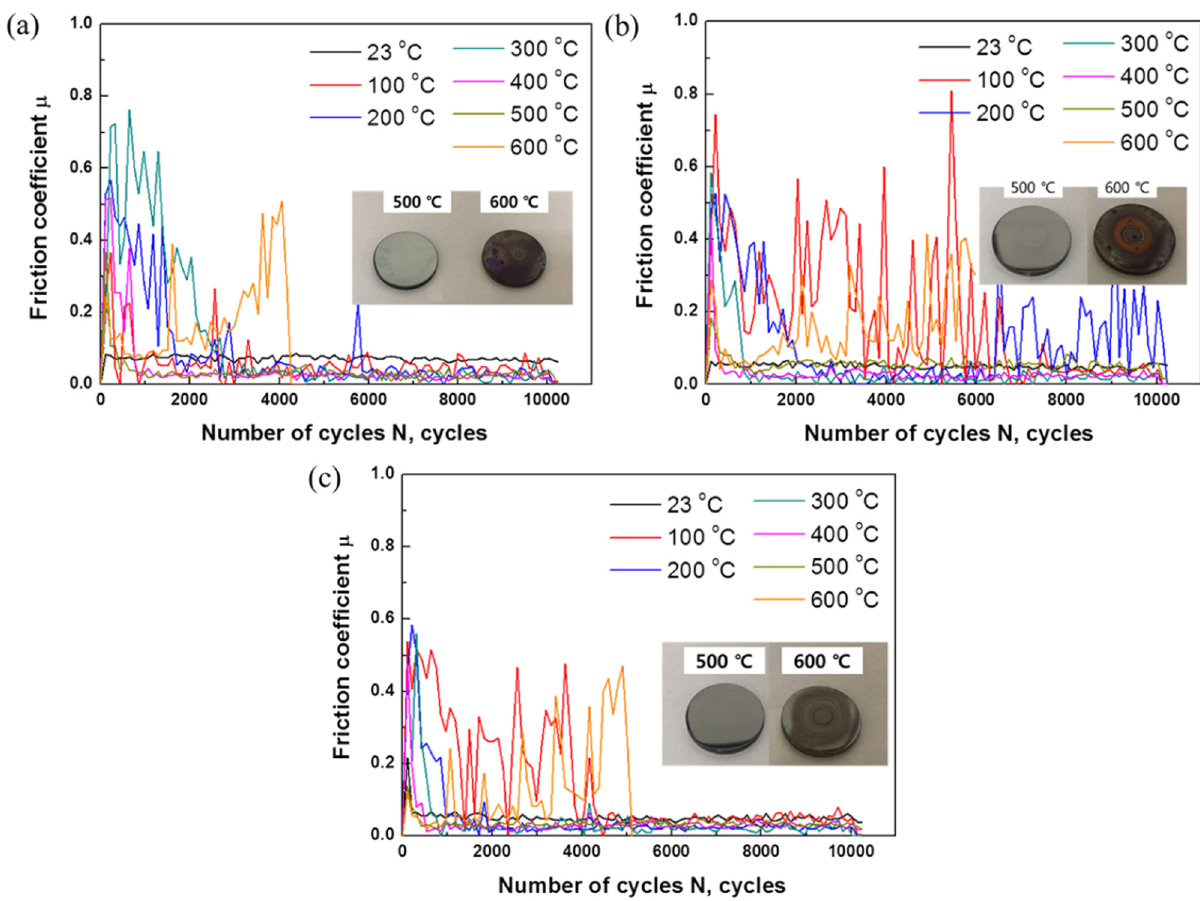
Figure 3: CoF of ta - C coatings fabricated by different substrate biases at ( a ) 0 V, ( b ) − 100 V, and ( c ) − 300 V as a function of the number of sliding cycles at elevated temperature [ 77 ]